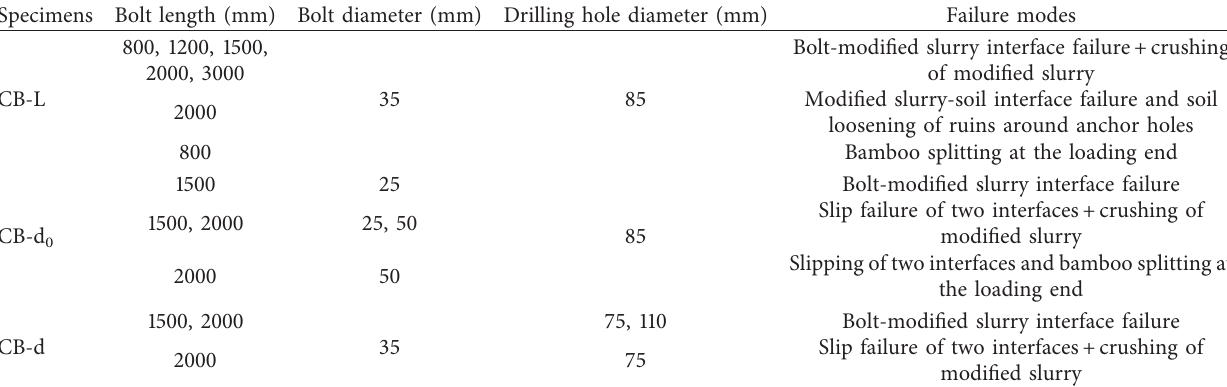
Figure 11: Failure mode: (a) bamboo bolt-modified slurry interface slip failure; (b) modified slurry-soil interface slip failure; (c) bamboo splitting at the loading end. Table 7: Failure modes of bolt